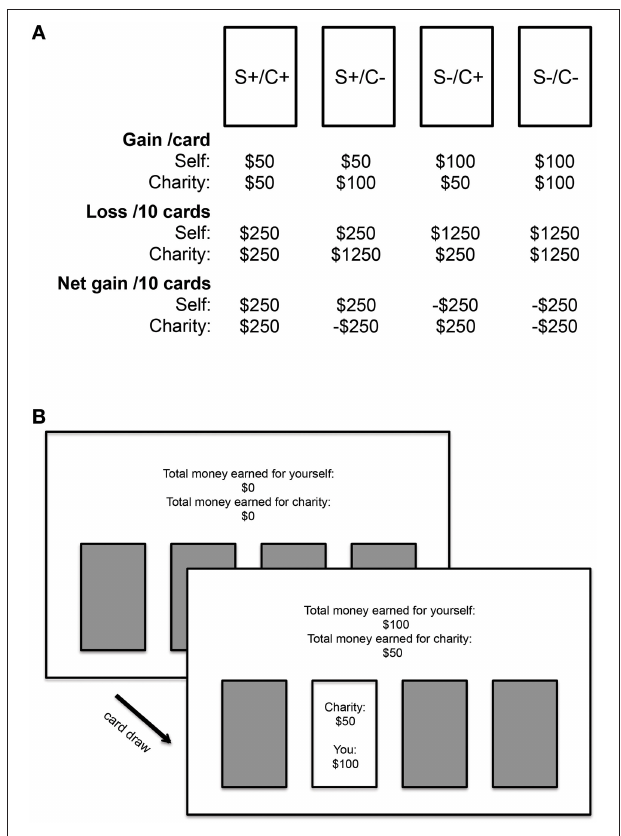
FIGURE 1 | Payout structure for each card deck of the Social Gambling Task (SGT). S = self, C = charity, + = gain deck, − = loss deck. For the gain decks, each card draw always gave $50 but in some trials it was also associated with losses ranging between $25 and $75 (i.e., loss of $25, $50, or $75). Each card draw only displayed the outcome combining the gain and loss, which ranged between − $25 to $50. Every 10 trials had 5 loss trials with a total loss of $250, thus resulting in a net gain of $250. For the loss decks, each card draw always gave $100 with some trials giving losses ranging between $150 and $350 (i.e., loss of $150, $200, $250, $300, or $350). The outcome displayed ranged between − $250 to $100. Every 10 trials had 5 loss trials with a total loss of $1250, thus resulting in a net loss of $250. (A) An example screen display of a trial in SGT (B) . Figure adapted from Kwak et al.